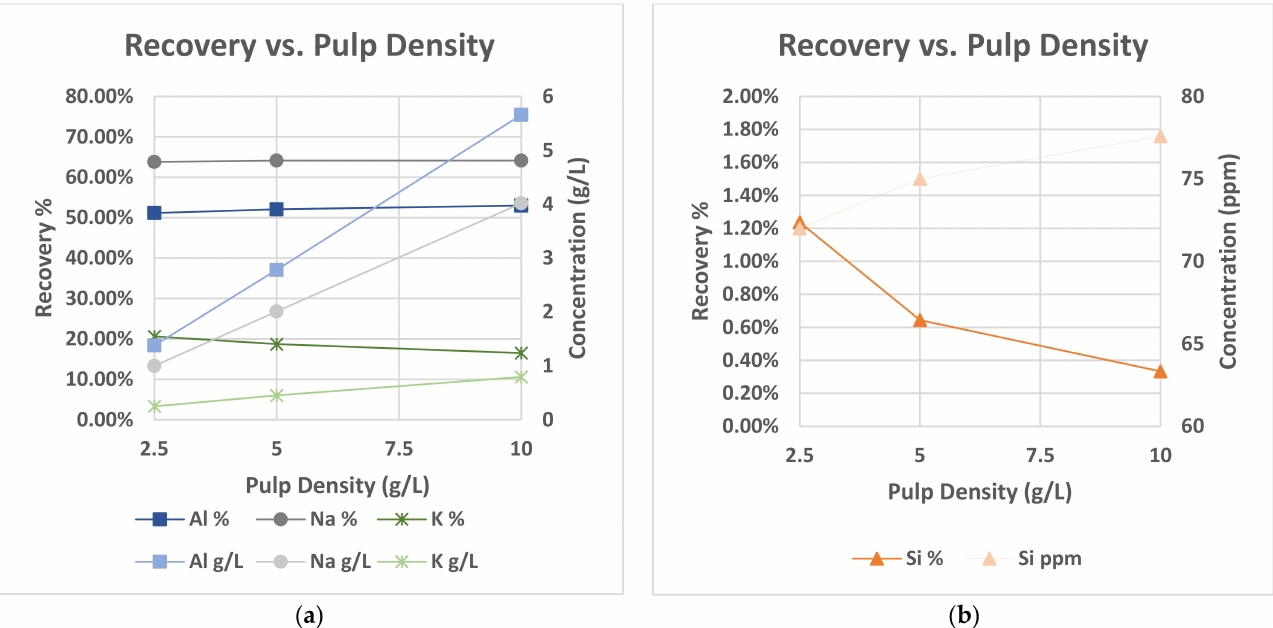
Figure 4. Effect of pulp density on the extraction of ( a ) Al, K, Na and ( b ) Si values (pulp density: 2.5% w / v , stirring rate: 300 rpm, HCl concentration: 5.89 M, temperature: 90 ◦ C).